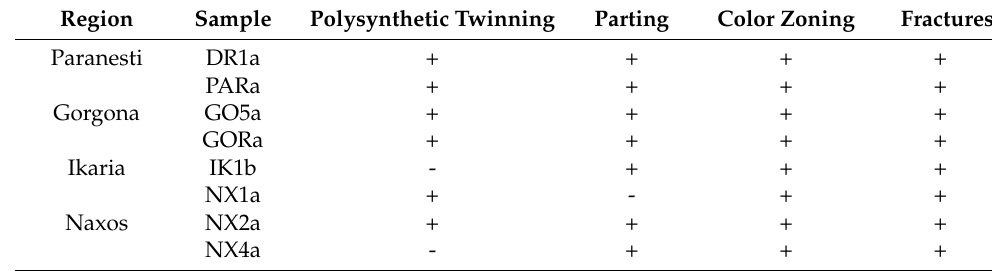
Table 2. Characteristic features of the Greek corundum studied under transmitted light microscope.